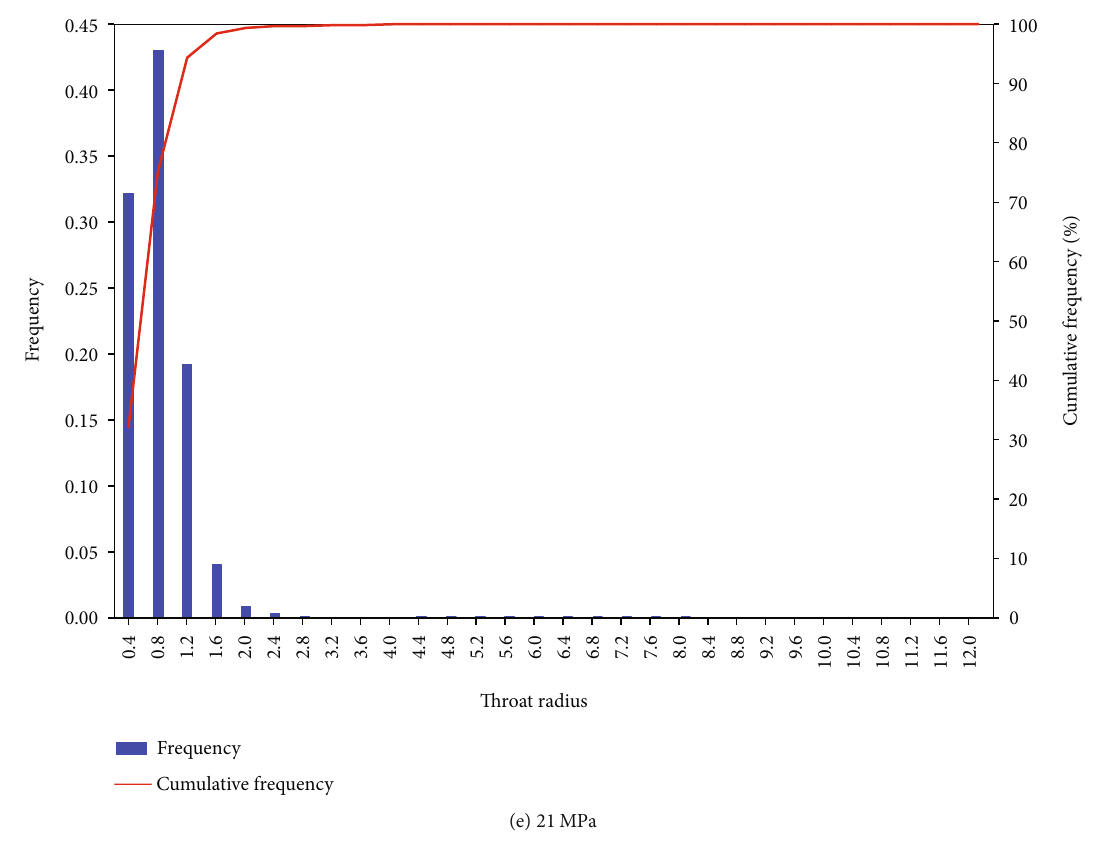
Figure 14: Frequency distribution of throat radii for simulated deformed digital